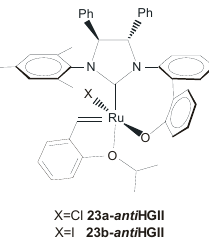
Figure 16. Catalyst 23- anti HGII with chiral bidentate NHC.